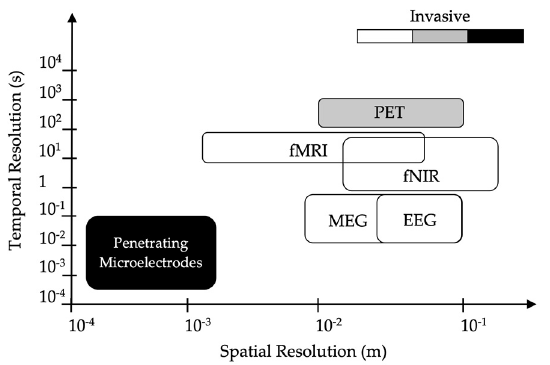
Figure 3. Spatial and temporal resolutions depending on signal acquisition technique.